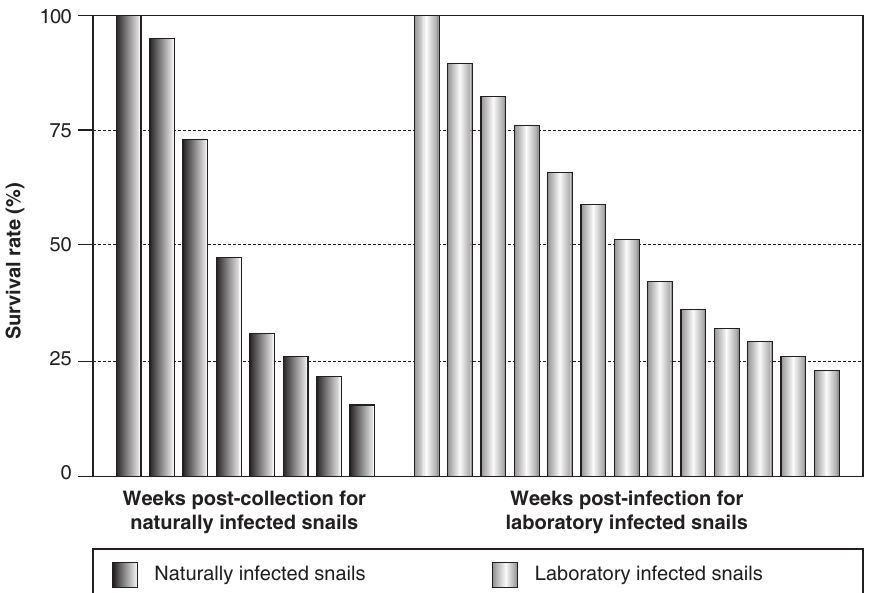
FIG. 1 Weekly survival rates (%) of Bulinus tropicus , either exper- imentally or naturally infected with Calicophoron microboth- rium